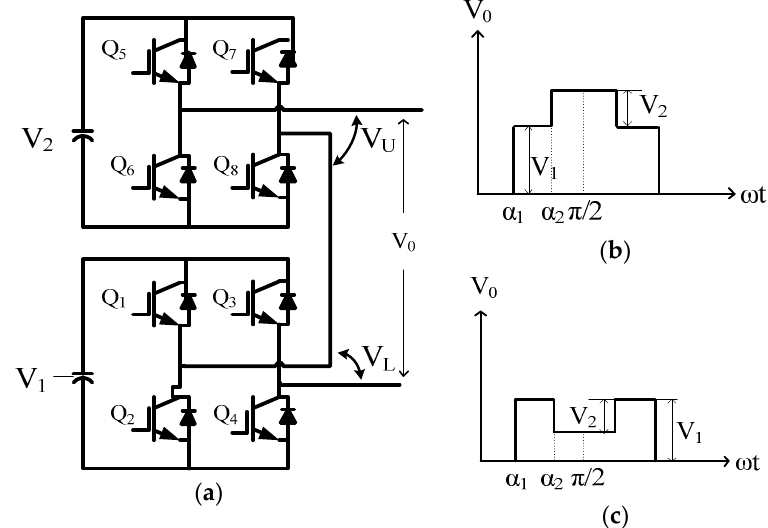
Figure 1. ( a ) Unequal DC sources of the cascaded single-phase five-level inverter and output waveforms when ( b ) α 1 < α 2 < π /2 and ( c ) α 1 < π /2 and α 2 > π /2 ( α 2 = π − α 2 ).